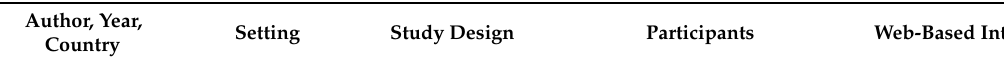
Table 2. Summary of narrative synthesis of included